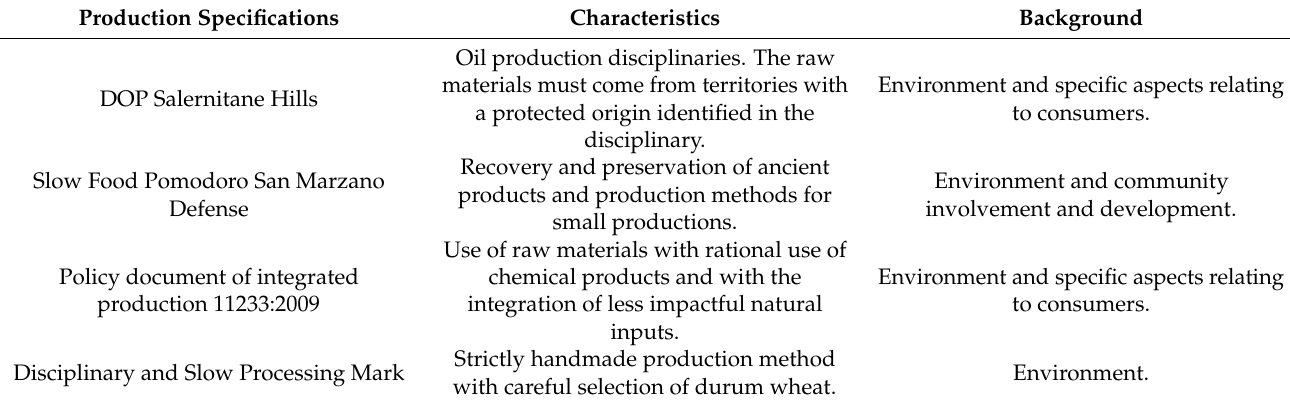
Table 3. Sustainability guidelines applied by the analyzed